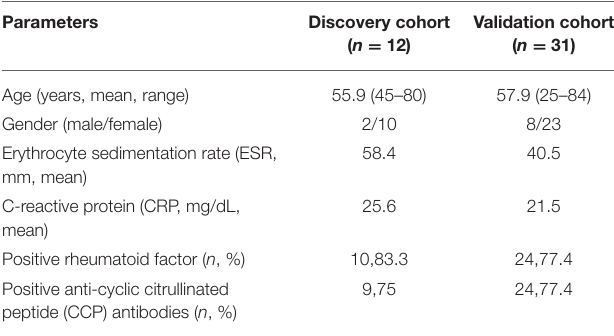
TABLE 1 | Clinical and laboratory parameters of RA patients enrolled in the current study.